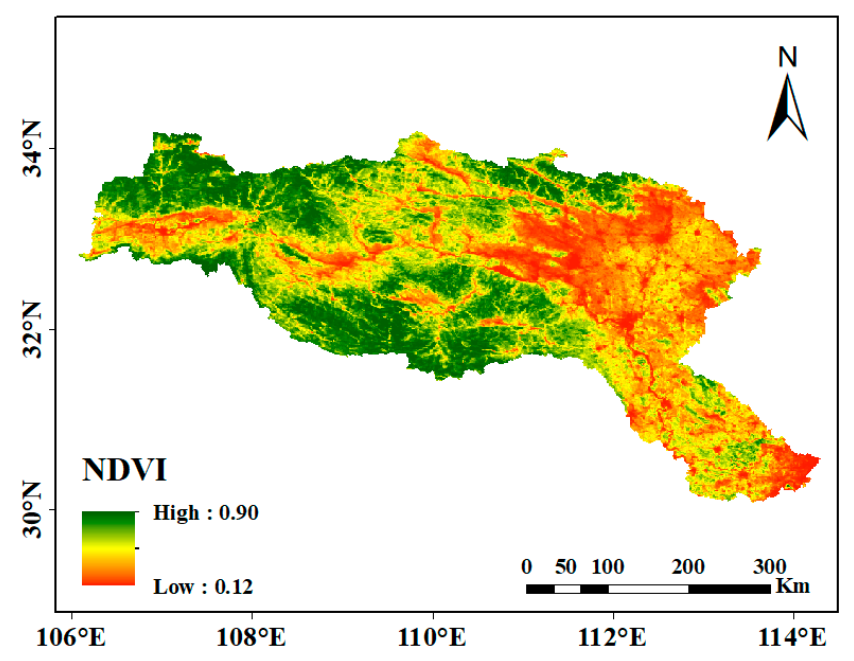
Figure 3. The distribution of NDVI in the HJRB. Remote Sens. 2020 , 12 , x FOR PEER REVIEW